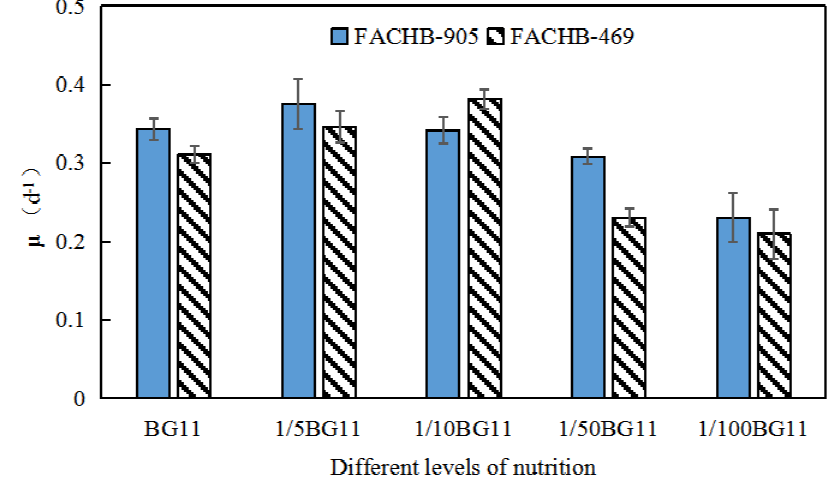
Figure 2. Changes of μ of FACHB-905 and FACHB-469 under different nutrition levels.